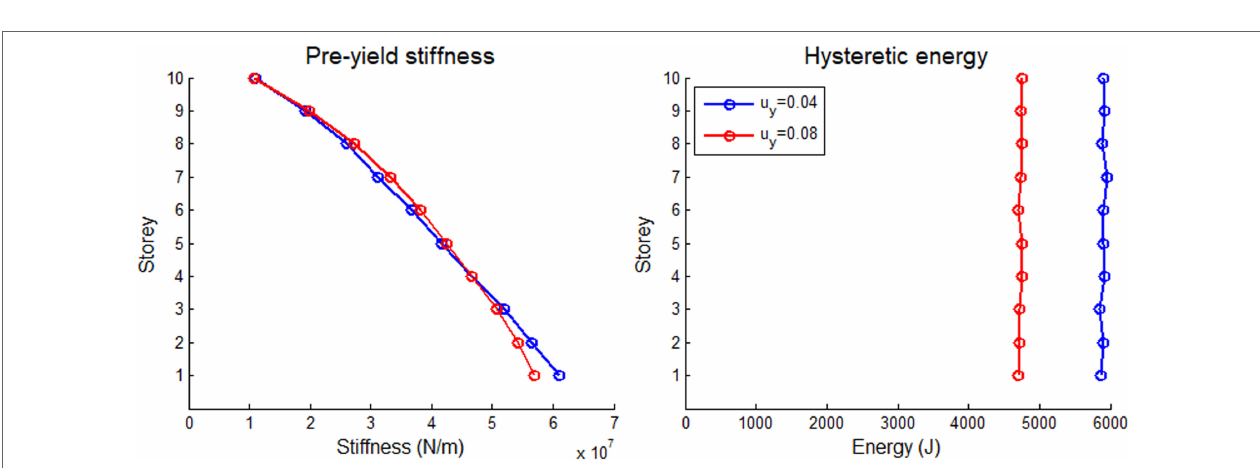
Frontiers in Built Environment |